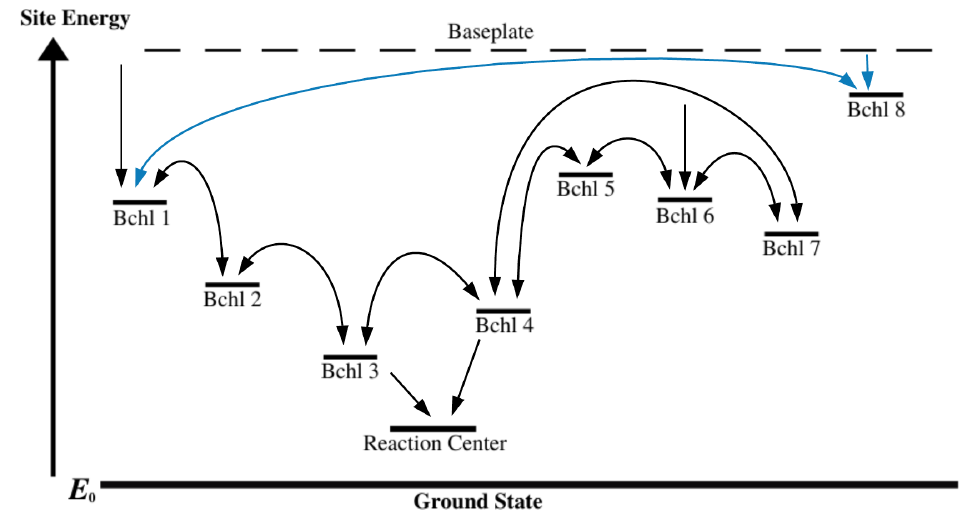
Figure 6. Diagram of the excitation energy transfer pathways in the FMO complex depicting the energies of each site and considering the participation of the additional eighth bacteriochlorophyll